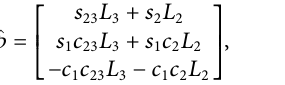
Frontiers in Robotics and AI |